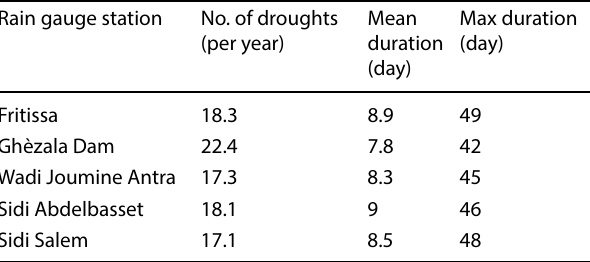
Table 7 General drought characteristics using a 1 mm threshold (based on a precipitation analysis), and a minimum duration of 3 days for the hydrometeorological variables Rain gauge